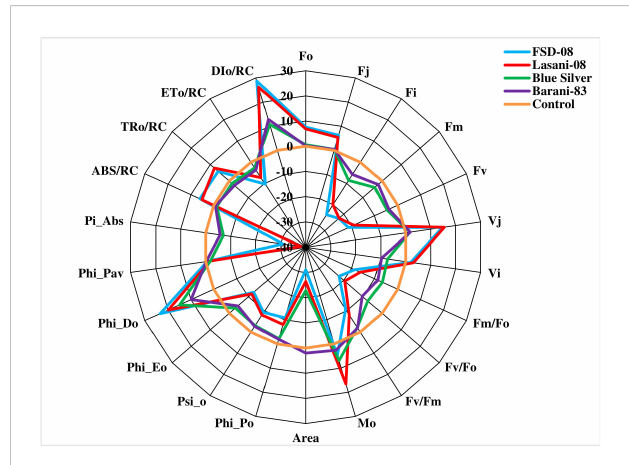
FIGURE 10 Radar plot of selected JIP test parameters showing changes in chlorophyll a fl uorescence transients (normalized to control as reference) of four selected wheat cultivars subjected to drought stress at adult growth